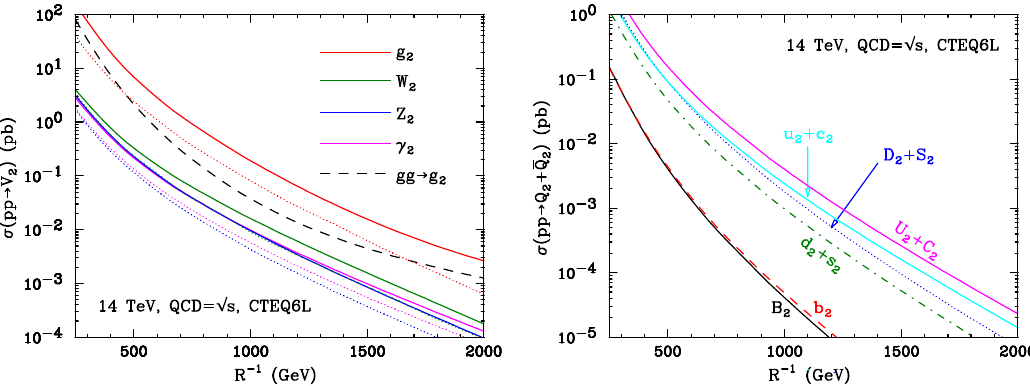
Figure 16 . Single production cross section of level-2 KK gauge bosons (left) and level-2 KK fermions (right) as a function of R (cid:0) 1 . Dotted curves (left) are results from ref. [21] and solid curves are new results including (cid:12)nite terms. Level-2 fermion cross sections and (cid:27) ( gg ! g 2 ) have been computed (cid:12)rst time. The cut-o(cid:11) scale has been set to (cid:3) R = 20.